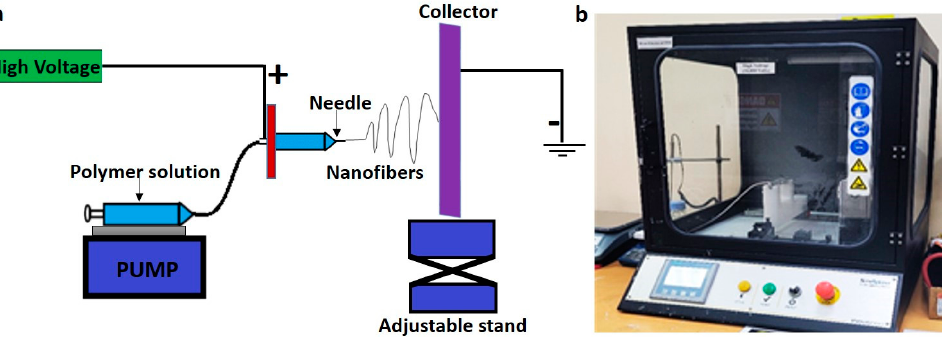
Figure 1 . A schematic of the electrospinning setup ( a ), and electrospinning unit in the lab ( b ).